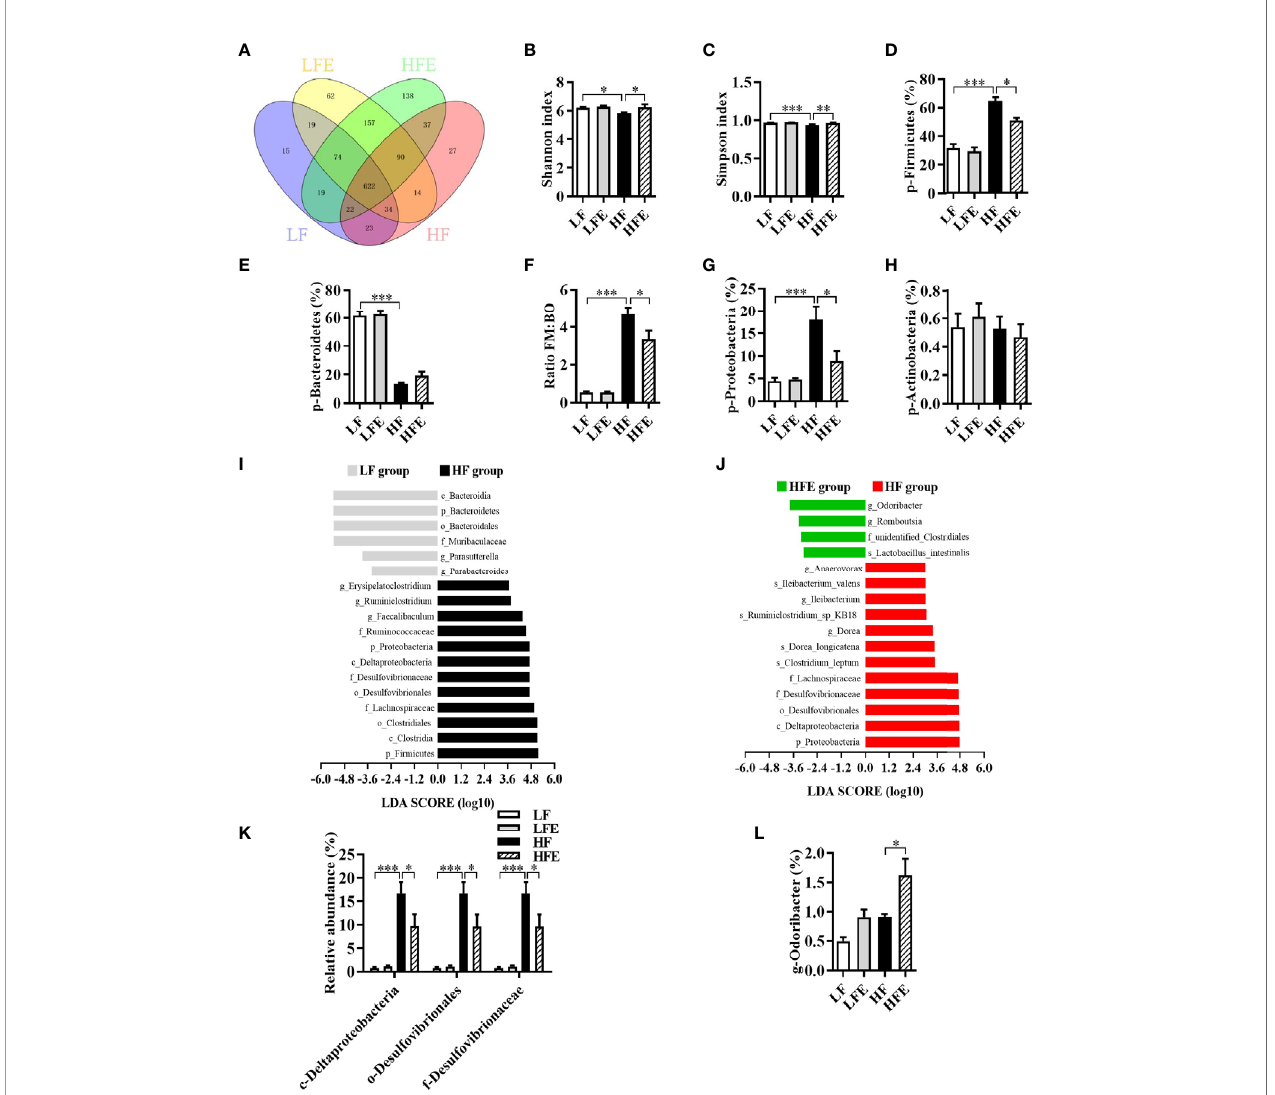
FIGURE 5 | ESPs supplementation attenuated gut microbiota dysbiosis in HF diet-induced obese mice. (A) Venn diagram of operational taxonomic units (OTUs). (B) Shannon index. (C) Simpson index. (D) Relative abundance of Firmicutes. (E) Relative abundance of Bacteroidetes. (F) Ratio of Firmicutes (FM) proportion to Bacteroidetes (BM) proportion (Ratio FM/BO). (G) Relative abundance of Proteobacteria. (H) Relative abundance of Actinobacteria. (I, J) Linear discriminant analysis (LDA) effect size (LEfSe) showing the most differentially signi fi cant abundant taxa enriched in microbiota from the HF vs . LF and HFE vs . HF groups. (K) Comparison of the representative taxonomic abundance of Proteobacteria among the LF, LFE, HF, and HFE groups at the class, order and family levels. (L) Comparison of the representative taxonomic abundance of Bacteroidetes among the LF, LFE, HF, and HFE groups at the genus level. Values are represented as mean ± SEM. n = 6. * P < 0.05, ** P < 0.01, *** P < 0.001. LDA score > 3.0 was considered signi fi cant. p, phylum; c, class; o, order; f, family; g,